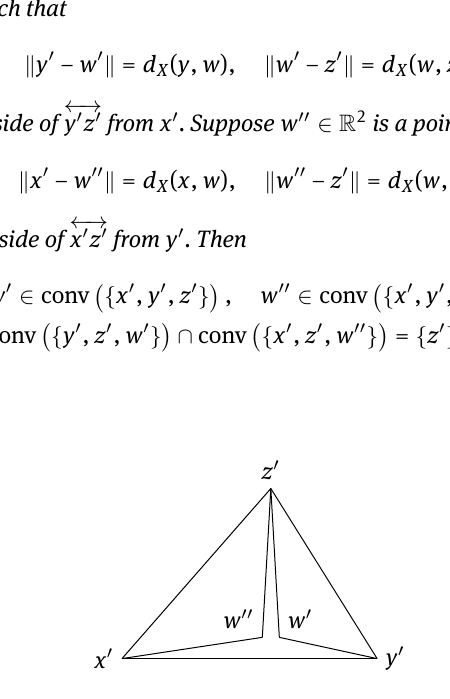
Figure 7.1: The points in R 2 appeared in the statement of Lemma